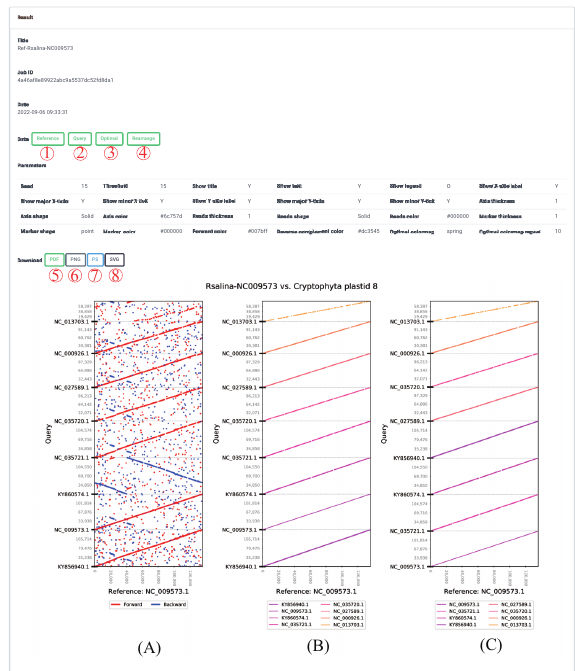
Figure 7. Submitted job results. 1 (cid:13) : Reference sequence file uploaded by the user. In ( A – C ), the x-axis refers to the reference sequence. 2 (cid:13) : Query sequence uploaded by the user. The input files are sequentially merged and provided as a single file. In ( A – C ), the y-axis refers to the query sequence. 3 (cid:13) : Based on the position of the reference sequence, modified positions and sequence information for the optimized query sequence can be checked based on the text. 4 (cid:13) : Query sequences with a low similarity to the reference sequence can be viewed in a top-down format, in ascending order. 5 (cid:13) – 8 (cid:13) : The generated cPlot results that can be downloaded in .pdf, .png, .ps, and .svg formats (download extension option is selected prior to cPlot execution).